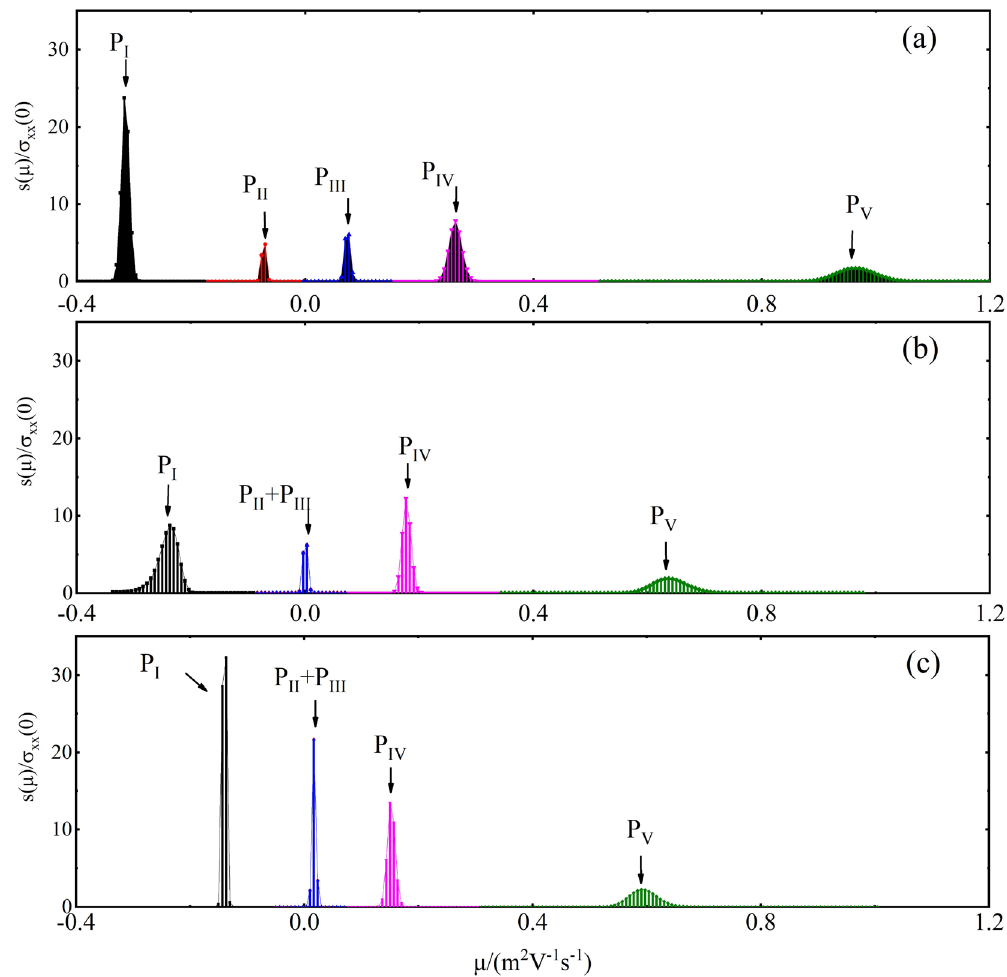
Figure 1. The MS of carriers in PtBi 2 for temperature T = 2 K ( a ), 10 K ( b ), and 20 K ( c ),